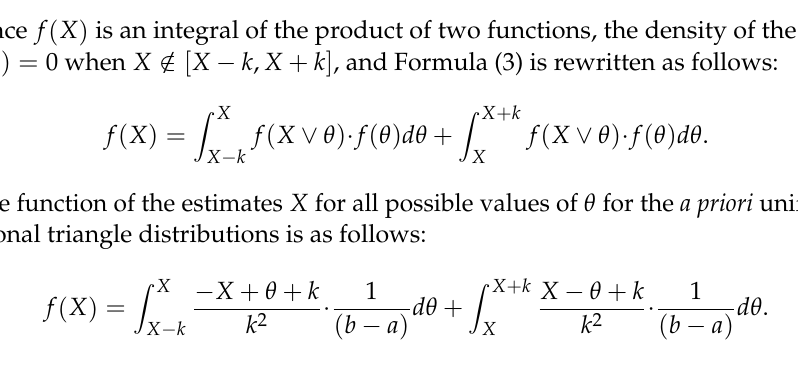
Figure 2. The probability density functions of uniform (a priori information) and triangle (expert error) distributions.